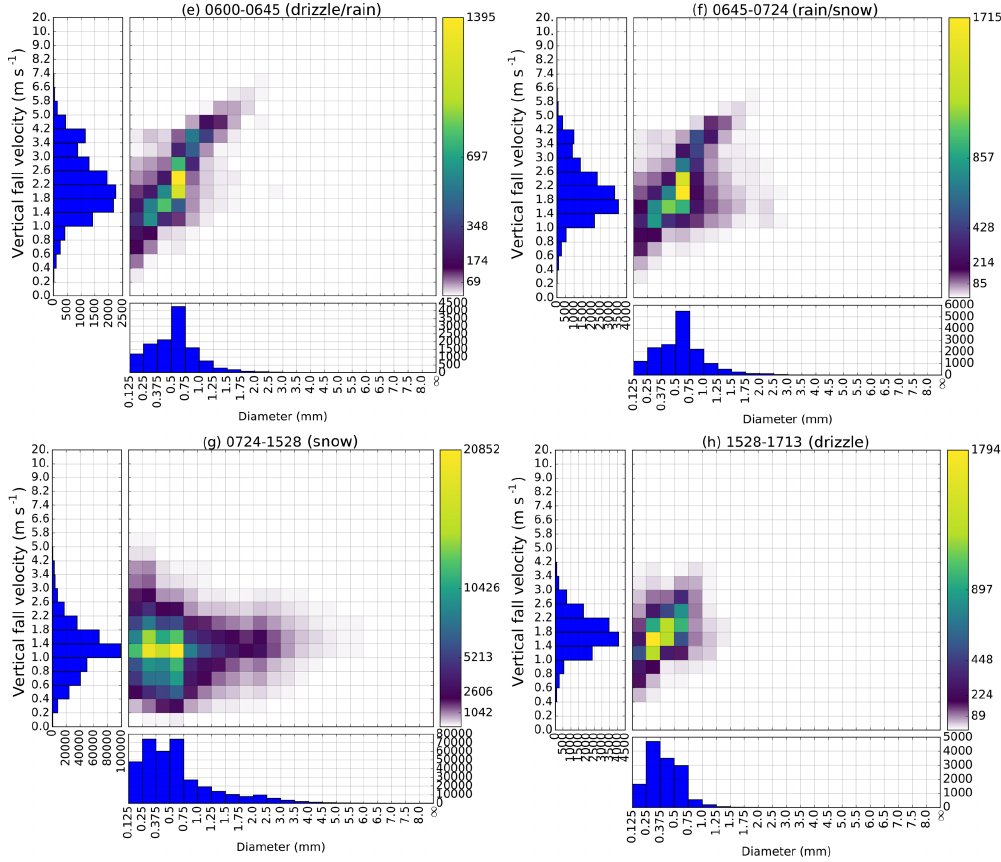
Figure 10. As in Fig. 9, but time periods are as follows: (e) 06:00–06:45 (drizzle/rain), (f) 06:45–07:24 (rain/snow), (g) 07:24–15:28 (snow), and (h) 15:28–17:13